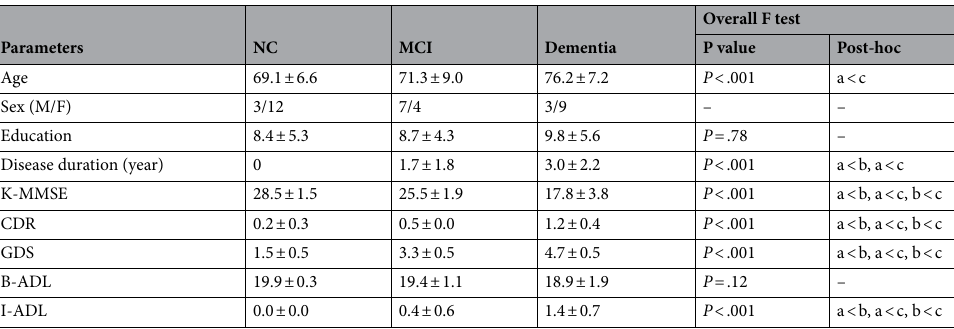
Table 2. Demographics and clinical characteristics. Mean ± standard deviations. NC normal controls, MCI mild cognitive impairment, dementia: clinically demented peoples, K-MMSE Korean Mini-Mental State